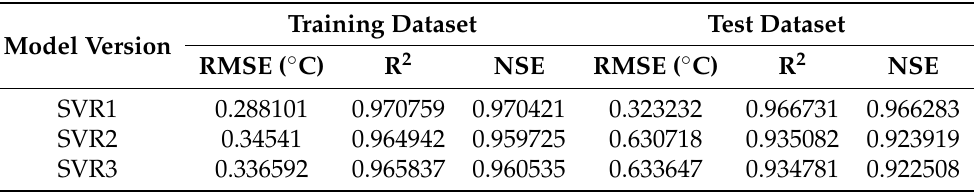
Table 6. Performances of SupportVector Regression in modeling water temperature (WT: ◦ C), SVR1: only one input variable (DOY), SVR2: with two input variables (DOY and Flow), SVR3: with all input variables.